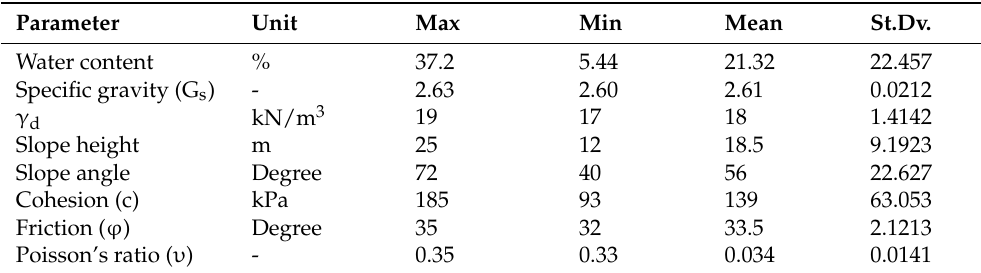
Table 3. Studied slopes’ geotechnical